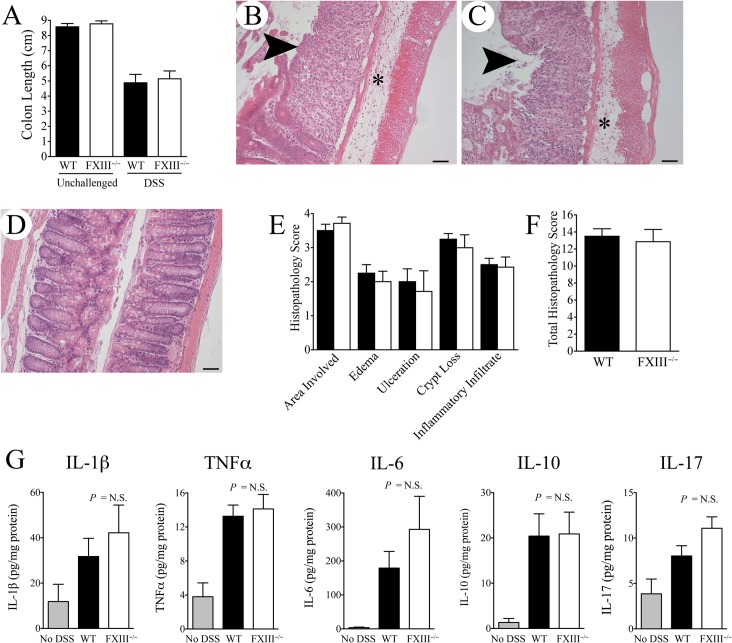
FXIII-deficiency does not alter initial colonic mucosal damage following 7 days of continuous DSS exposure.(A) Colons harvested from FXIII−/− and WT mice immediately after 7 days of DSS challenge (n = 10 per cohort) were significantly shorter than colons harvested from unchallenged mice (n = 4 per cohort), consistent with severe colitis (P < 0.01 for each comparison). However, colon lengths were similar in animals of both genotypes following 7 days of DSS exposure indicating comparable levels of initial disease. H&E stained sections of colonic tissue harvested from both WT (B) and FXIII−/− mice (C) had similar evidence of significant mucosal ulceration (arrowheads) and inflammatory edema (*). (D) An unchallenged colon cut in the same plane is shown for comparison. Size bars represent 50 μm. These observations were confirmed using a semi-quantitative multiparameter histopathological scoring system. Shown are the results for each individual parameter (E) and the summation of each parameter yielding a total disease score (F). Black bars and white bars represent WT and FXIII−/− cohorts (n = 10 per cohort), respectively. P = N.S for each comparison, Mann-Whitney U test. (G) Shown are the levels of inflammatory cytokines measured in colonic homogenates harvested from WT (n = 12) and FXIII−/− mice (n = 11) immediately following 7 days of DSS challenge as well as levels in colons harvested from unchallenged mice (n = 5). Note that levels of each cytokine measured were significantly elevated in DSS-challenged colons relative to those from unchallenged mice, but FXIII genotype had no significant effect on local cytokine levels.